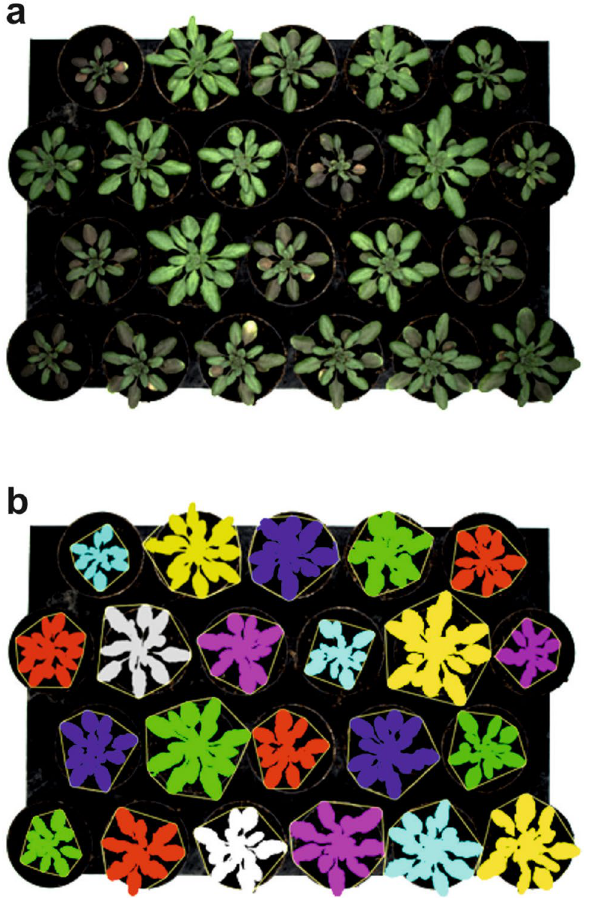
Figure 2. Image segmentation separating plants with green or reddish leaves from brownish background. Plants with reddish leaves are difficult to identify correctly using a phenotyping instrument based on RGB imaging unless training is performed and specific machine-learning algorithms are used. ( a ) Tray with Arabidopsis plants with different leaf colors. ( b ) Segmented image obtained with the software developed here, showing that almost all pixels are correctly associated with plants, regardless of their leaf color. Pixels related to each plant are colored as overlay on the original image. The convex hull area of the plants is also shown as a thin yellow line around the plant